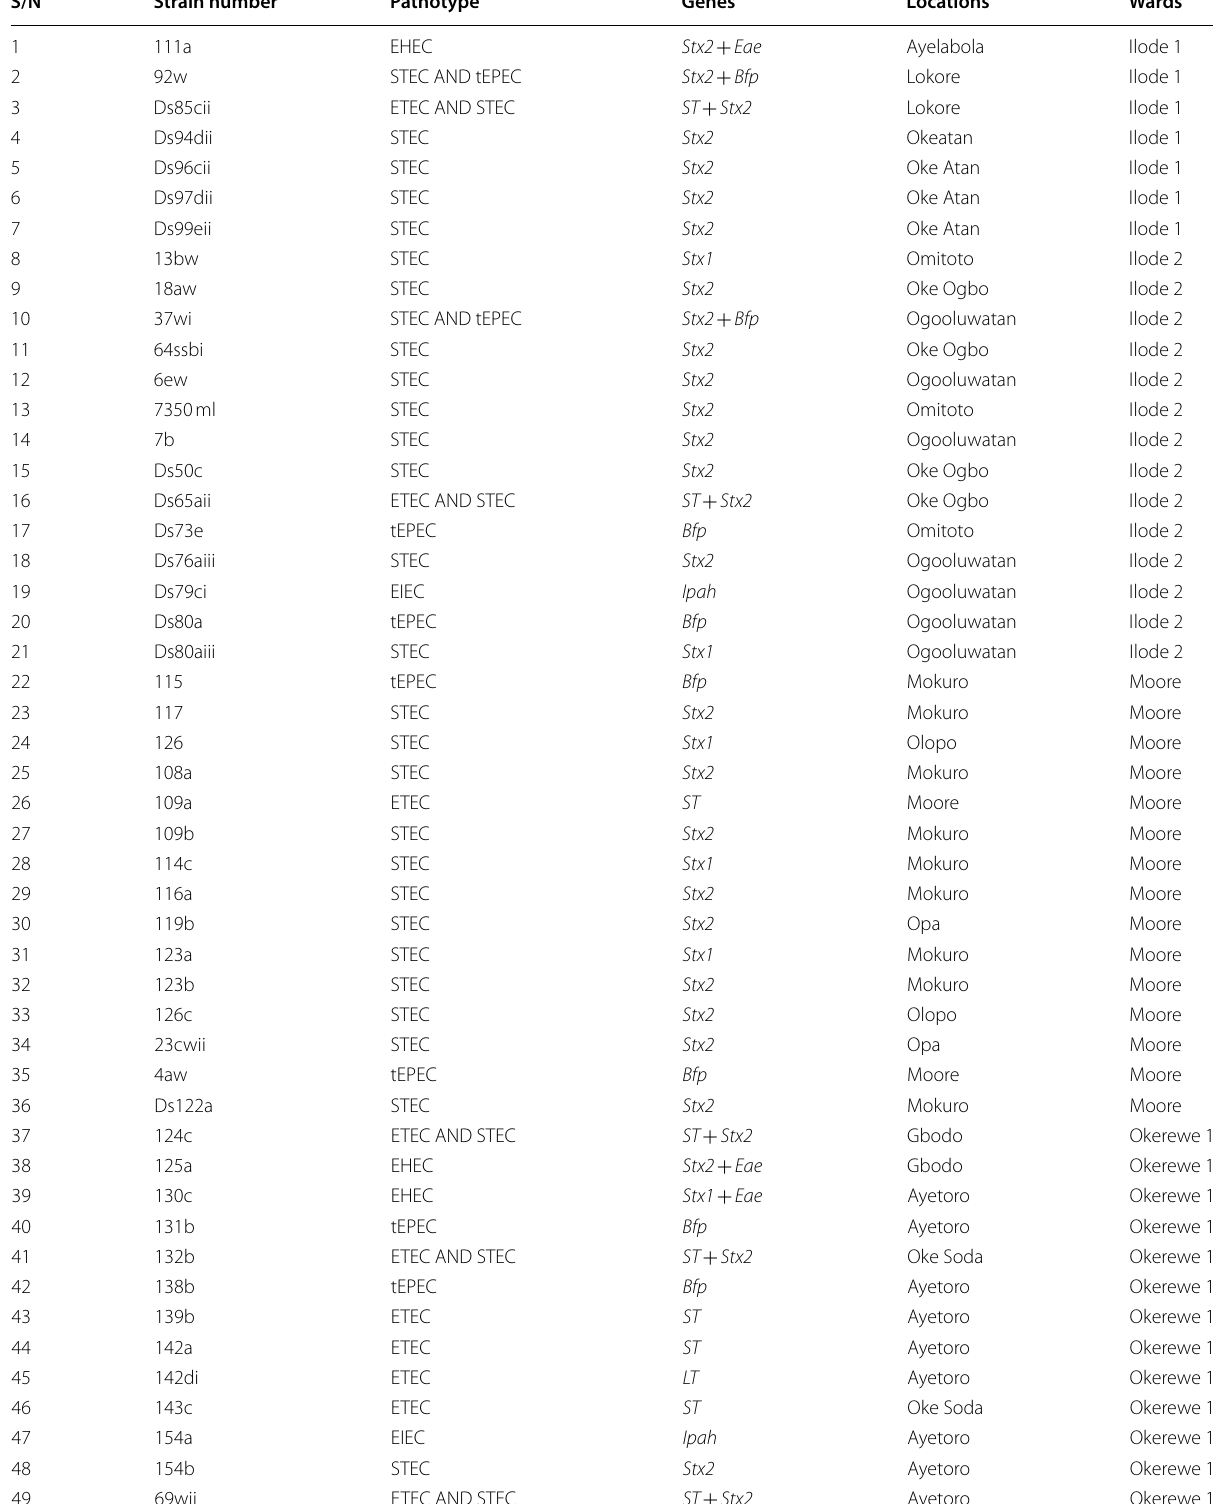
Table 5 Number and type of DEC isolated from sampled locations S/N Strain number Pathotype Genes